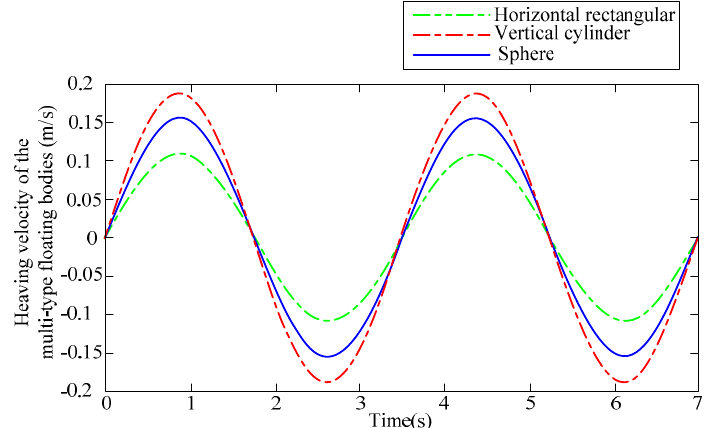
Figure 5. The heaving velocity of the multi-type floating bodies ( H = 0.3 m, T = 3.5 s).